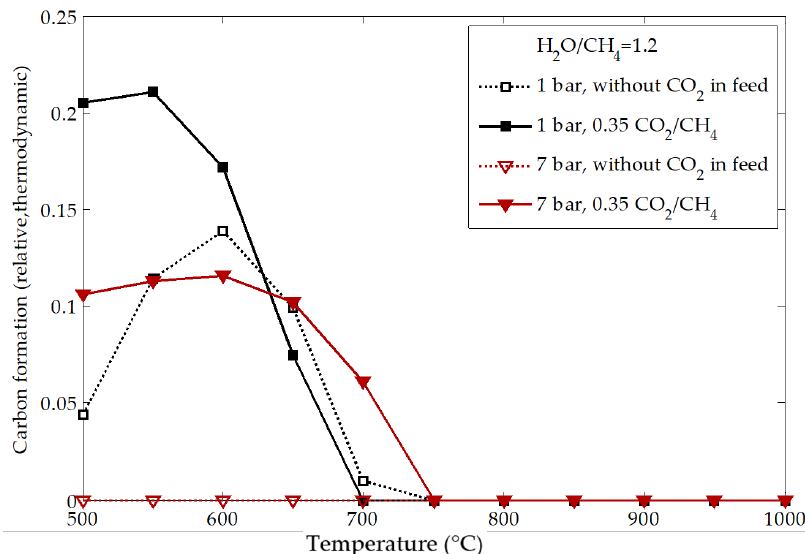
Figure 2. Carbon formation over temperature for 1 bar and 7 bar pressure, with H 2 O/CH 4 of 1.2 at the inlet. For CO 2 /CH 4 of 0.35 and 0 at the inlet.